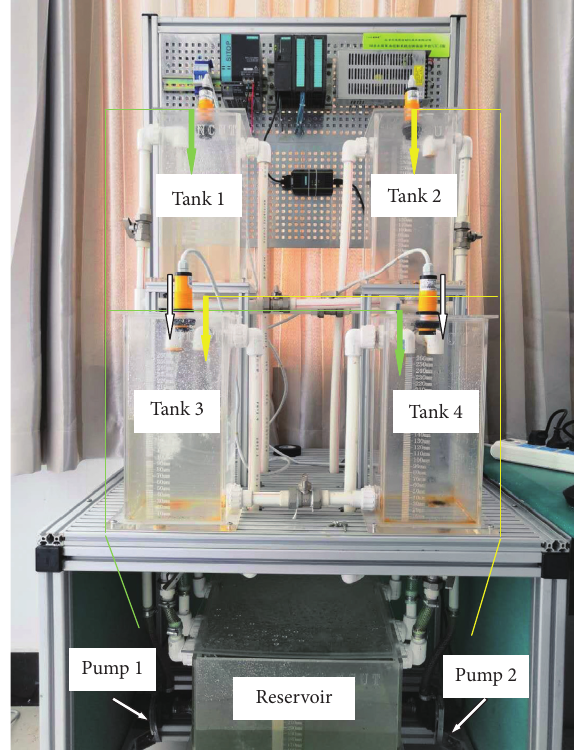
Figure 6: Experimental